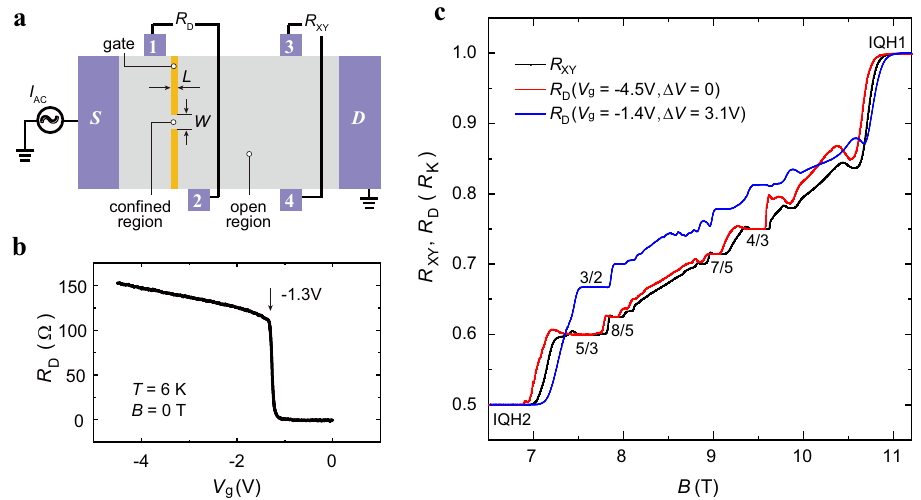
Fig.1|Samplegeometry,diagonalresistance R D versusgatevoltage V g ,and R D and Hall resistance R XY versus magnetic fi eld. a The Hall bar devices are 150 μ m wide and metal split gates de fi ne regions of L =1 μ m and W =2 μ m. R D measures diagonal resistance across the con fi ned region while R XY measures the Hall resis- tanceoftheopenregion. b R D asafunctionof V g at T =6Kandzeromagnetic fi eld. Electrons are depleted at V g ≈ (cid:3) 1 : 3V, which is shown as a step-like increase in the